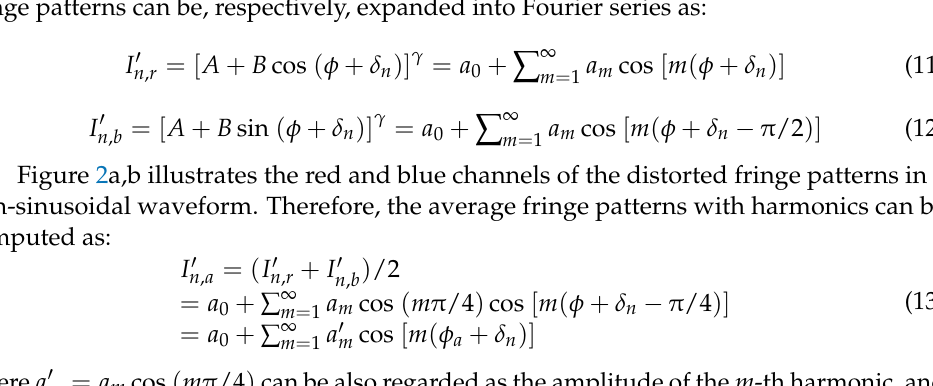
Figure 1. Principle of the proposed IDTP algorithm.